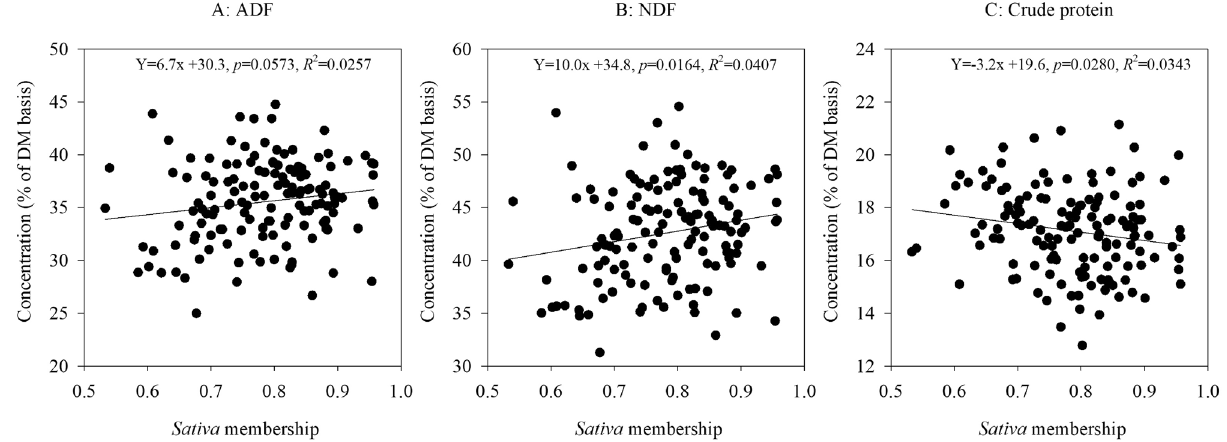
Figure 6. Regression between STRU CTU RE sativa parentage (%) and values of three nutritive traits of 14 alfalfa populations from long-term grazing